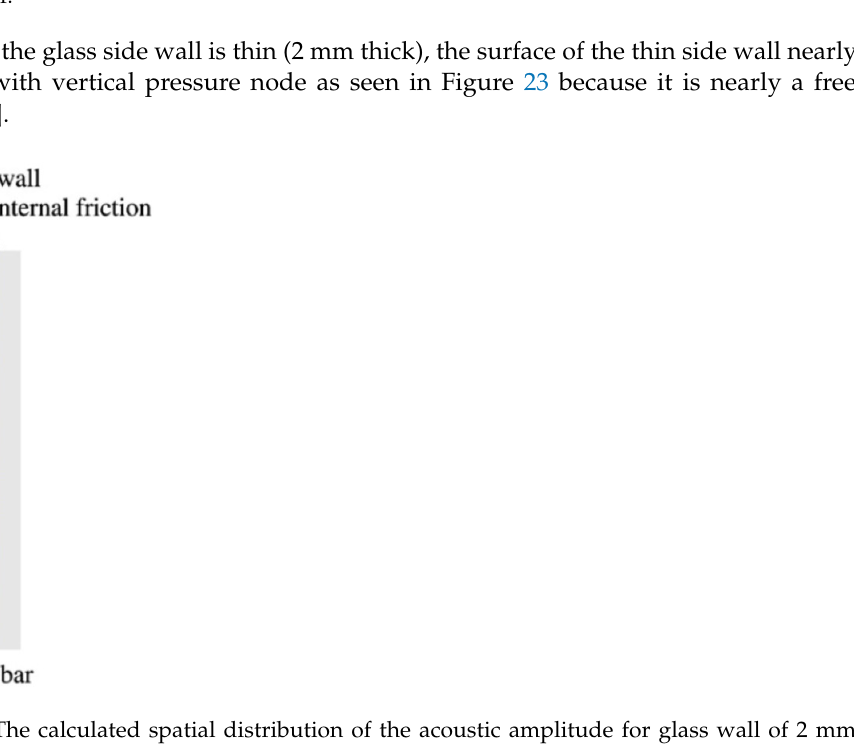
Figure 23. The calculated spatial distribution of the acoustic amplitude for glass wall of 2 mm in thickness [66]. The attenuation coefficient is 5 m − 1 . Copyright 2007, with the permission from Else- vier.